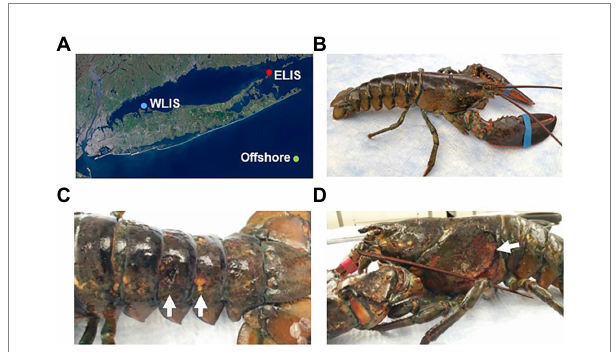
FIGURE 1 Collection of American lobsters from Long Island